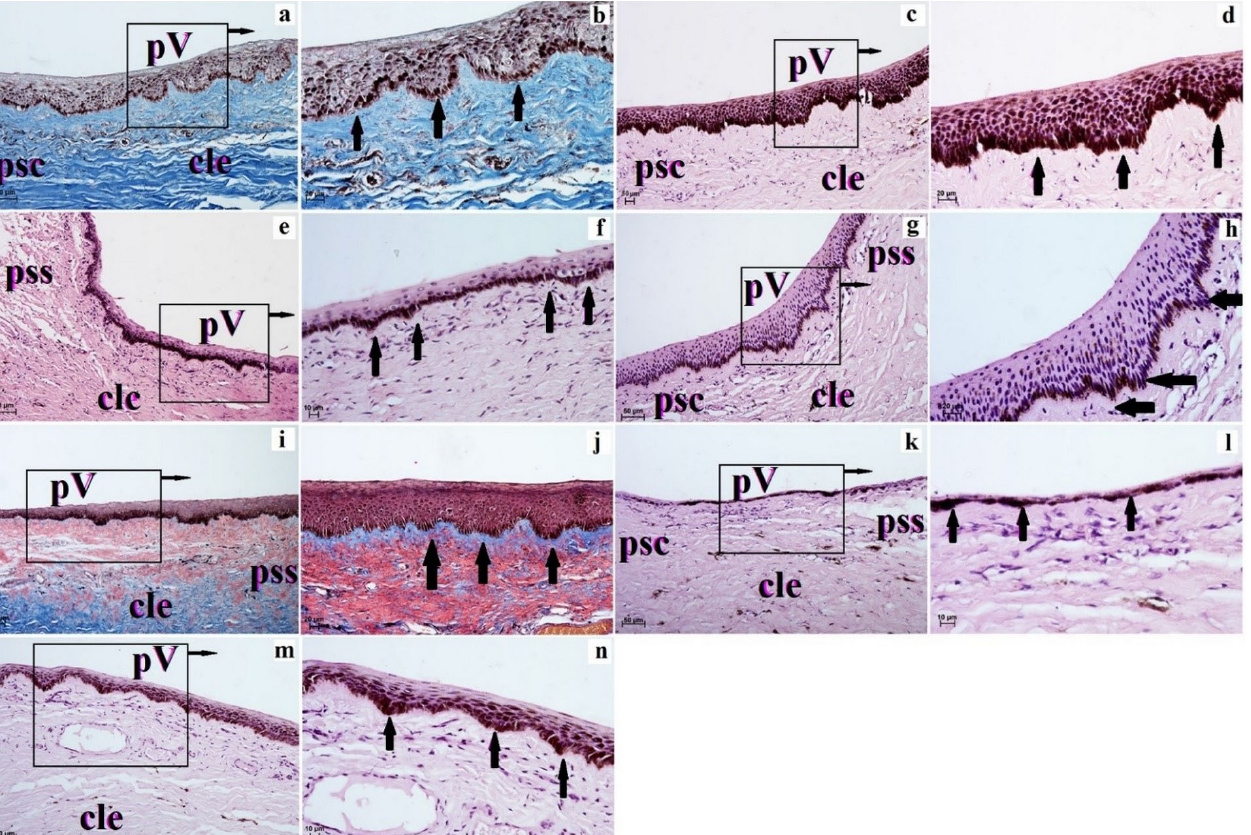
Figure 4. The photomicrograph of the palisades of Vogt in the examined ruminants. H&E stain ( c –